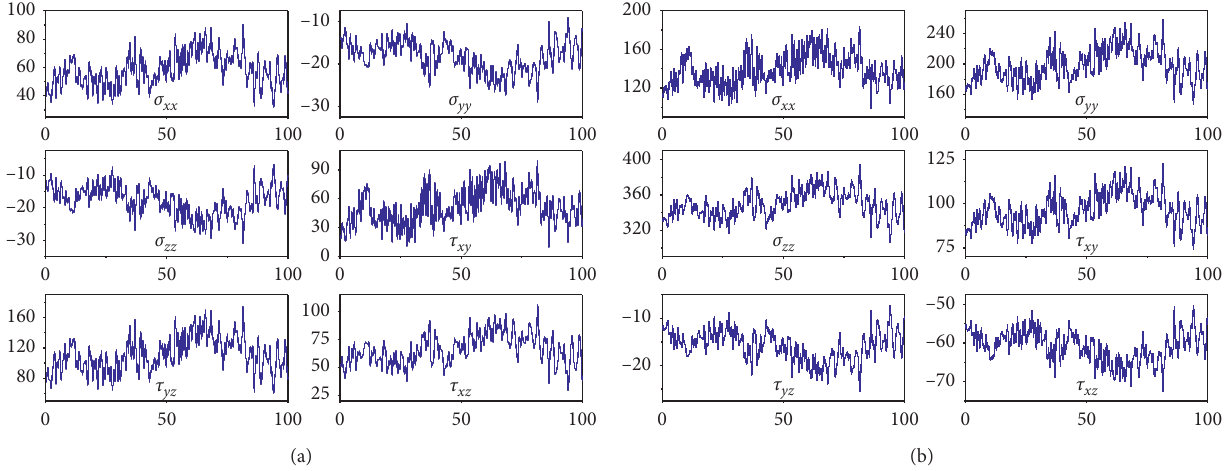
Figure 11: Multi-dimensional stress time history at the fatigue hazard point of key welded joint. (a) “Wind-induced” case. (b) “Welding- wind-induced”